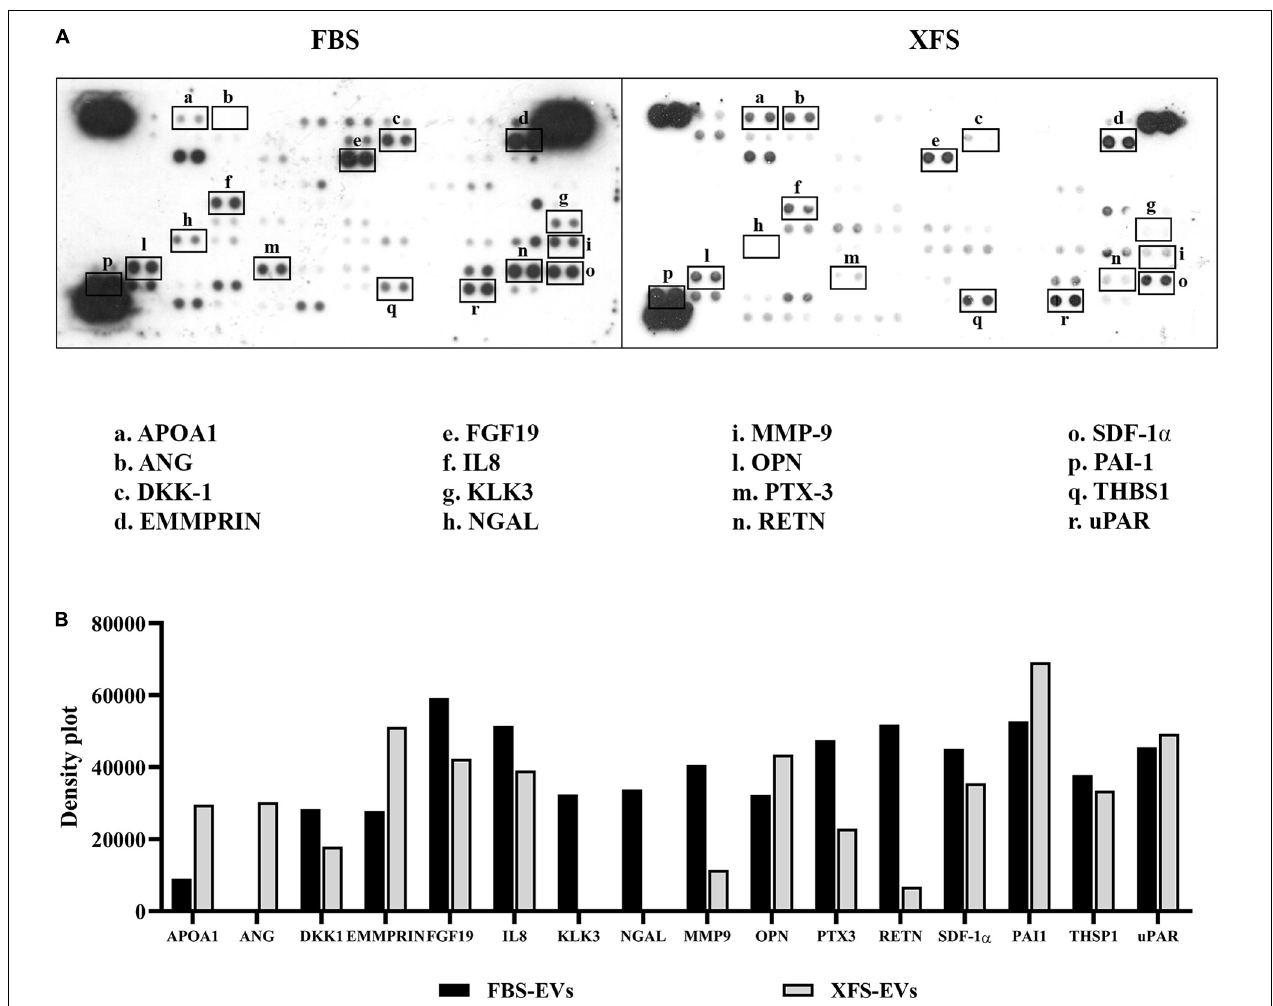
FIGURE 9 | Characterization of protein profile of EVs derived from hBMSCs cultured in FBS- or XFS-containing medium. (A) Cytokine array membrane of hBMSCs-EVs (FBS-EVs and XFS-EVs) representative of a single experiment performed on a pool of EVs derived from three different primary cultures. (B) Quantification of the integrated pixel density for each identified cytokine using Fiji ImageJ. Data are shown as mean. APOA1: apolipoprotein A1; ANG: angiogenin; DKK-1: dickkopf-1 WNT signaling pathway inhibitor; FGF-19: fibroblast growth factors; IL8: interleukin-8; KLK3: Kallikrein 3; NGAL: lipocalin-2; MMP-9: metalloproteinase-9; OPN: osteopontin; PTX-3: pentraxin-3; RETN: resistin; SDF-1 α : stromal cell derived factor 1 α ; PAI-1: serpin E1; THSP-1: thrombospondin-1; uPAR: plasminogen activator,